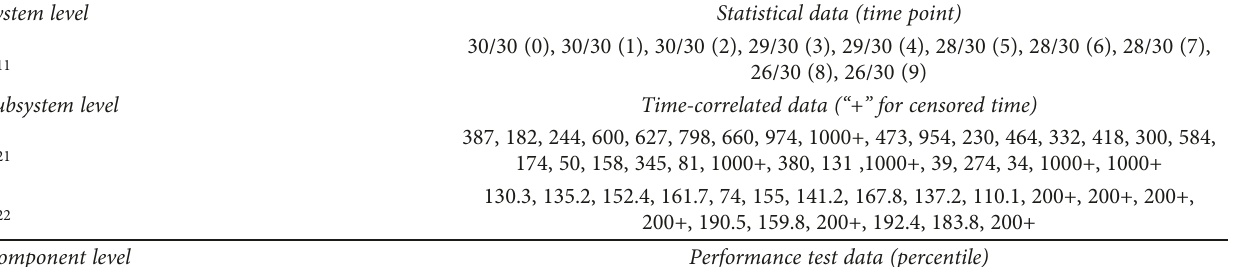
Table 5: Heterogeneous data sets used for the numerical case in Section 4 are displayed below. It is noted that all performance test data in various units have been